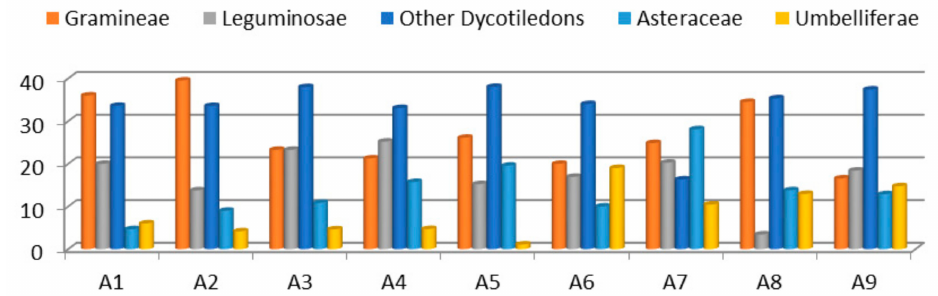
Figure 1. Main forage groups (as the mean percentages of the total number of collected plants) present in the pastures